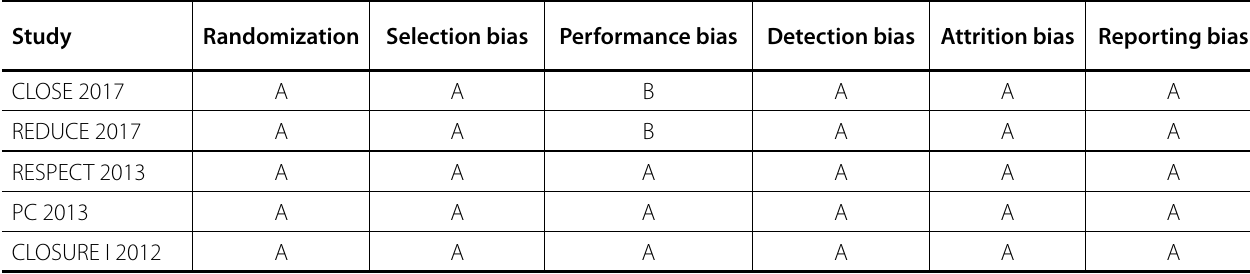
Table 2. Analysis of risk of bias: internal